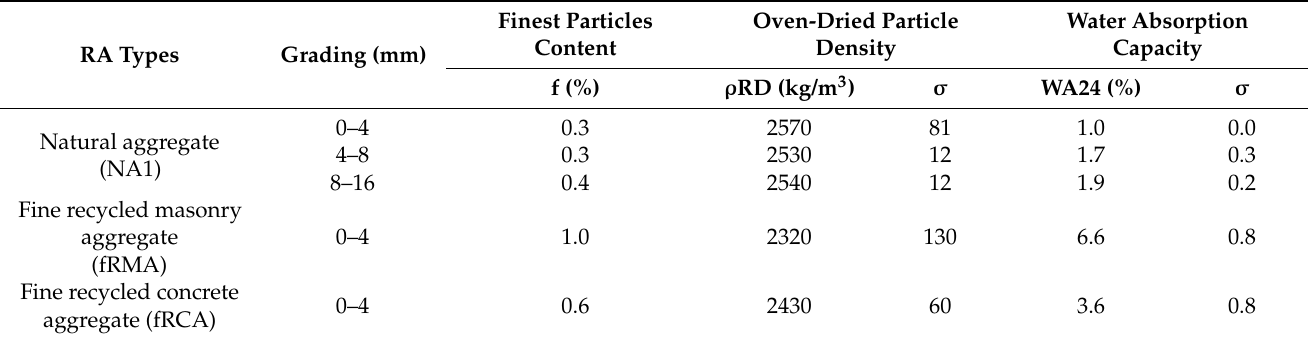
Table 1. The physical properties of each fraction of aggregates used for concrete mixtures.